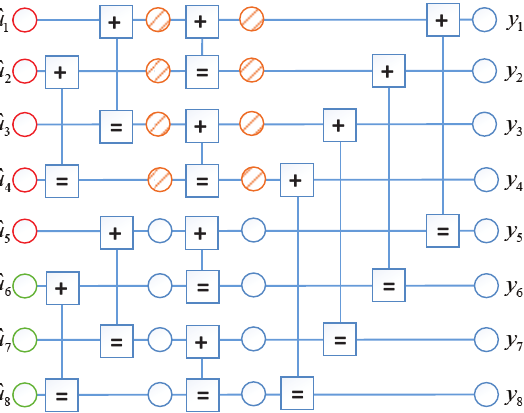
Figure 4. The factor graph of ( 8,3 ) polar codes with interval set s = [ 2,1,4 ]